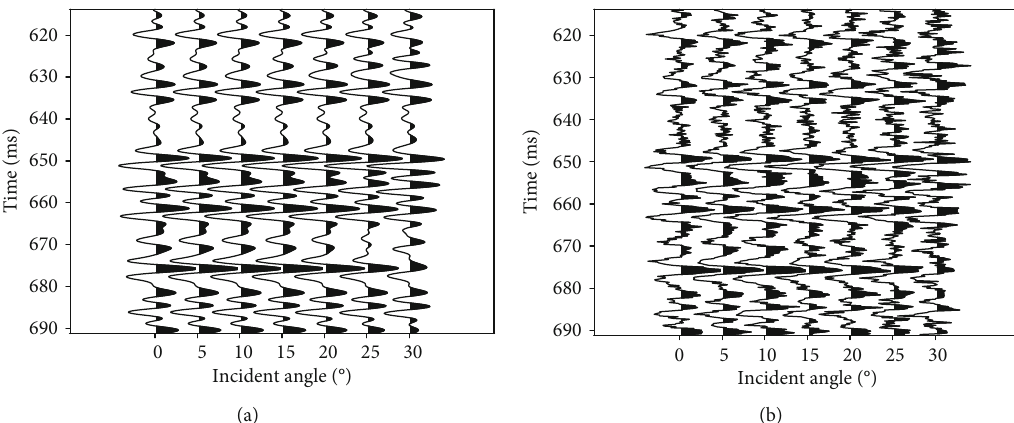
Figure 4: The synthetic angle gathers with incident angles ranging from 0 ° to 30 ° obtained using the true model parameters: (a) noise-free data; (b) noisy data with S/N = 5